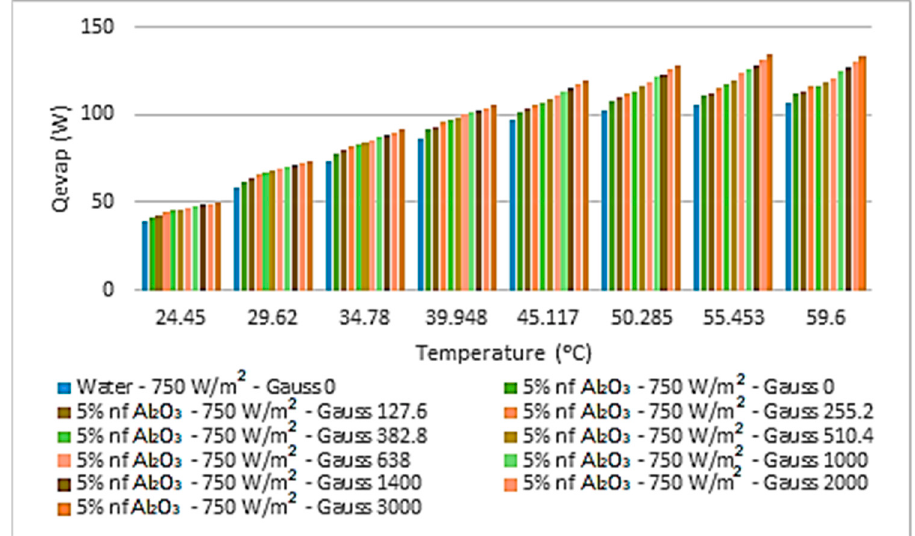
Figure 5. Thermal energy at heat pipe evaporator generated by PV-Th solar panels.